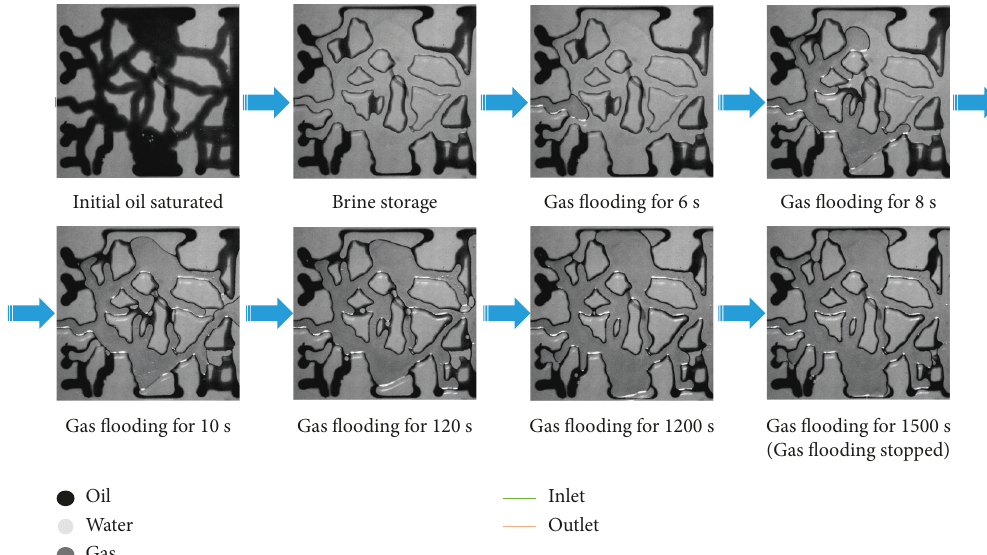
Figure 6: The complete process of TSD by gas flooding based on microfluidic visualization